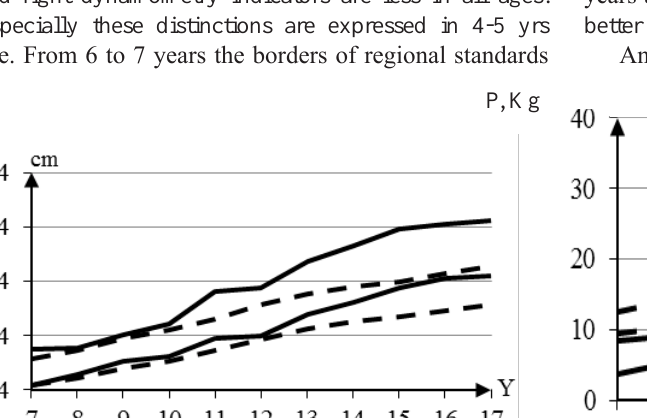
Fig. 8 . Comparative CC characteristics: O– cm; Y – age, years